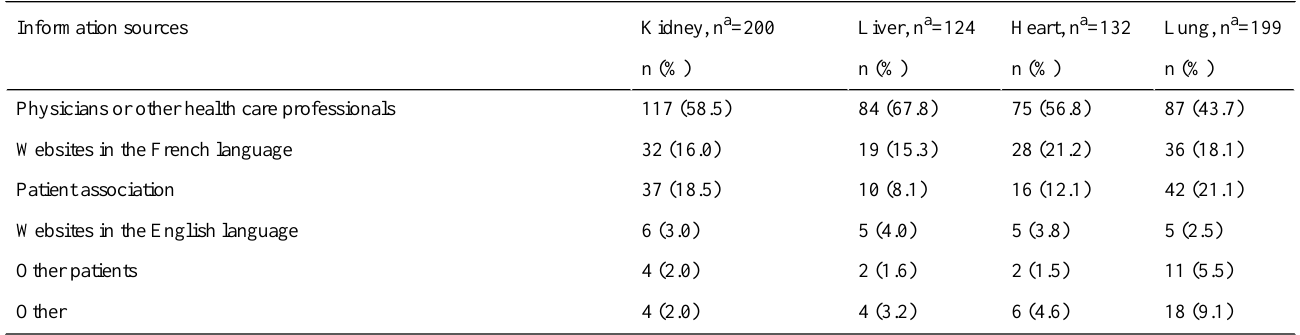
Table 1. Distribution of information sources for patients of each type of transplantation ( P <.001).